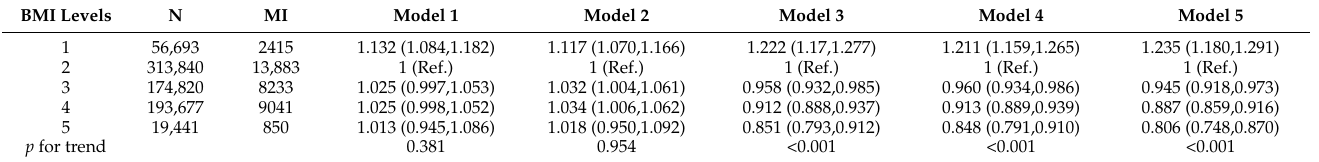
Table 3. Cox’s proportional hazard model for the incidence of new-onset MI according to